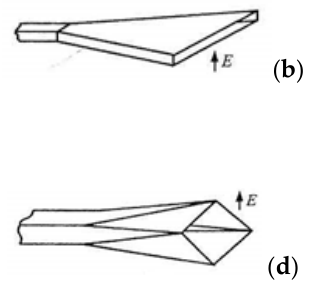
8 of 23 Figure 8. Analysis of the magnetron output signal.